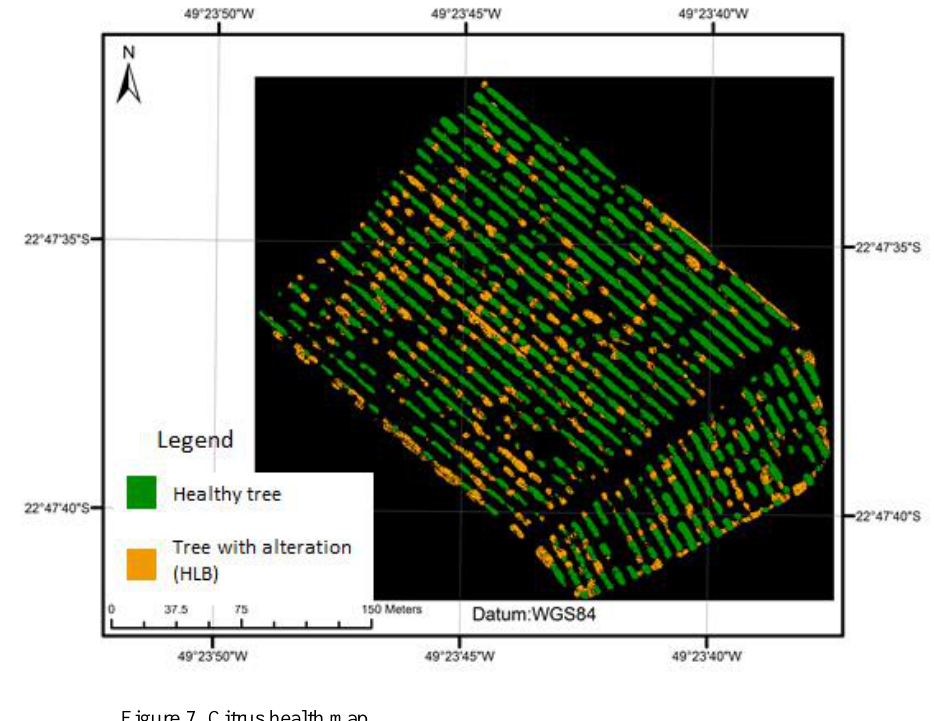
Figure 7. Citrus health